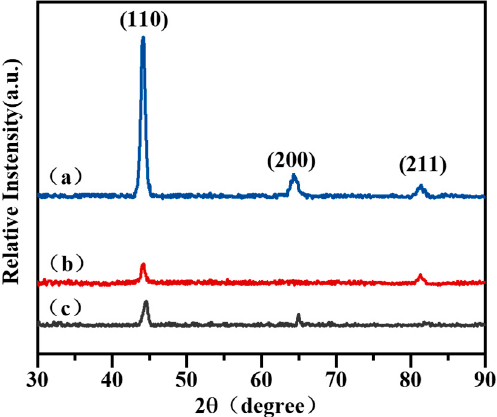
Figure 2. The XRD pattern of chromium coating surface is normalized with the peak of maximum strength, showing the difference in crystal orientation. ( a ) MAIP; ( b ) MSIP; ( c ) EPHC.